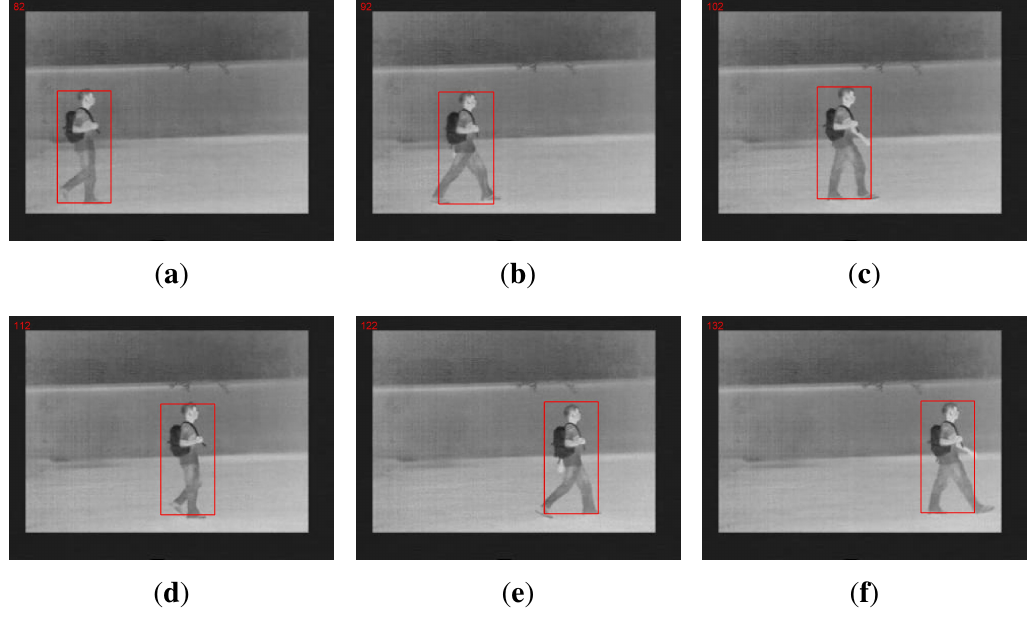
Figure 2. Sample tracking results for the forward-looking infrared (FLIR) video (red boxes highlight the locations of the walking